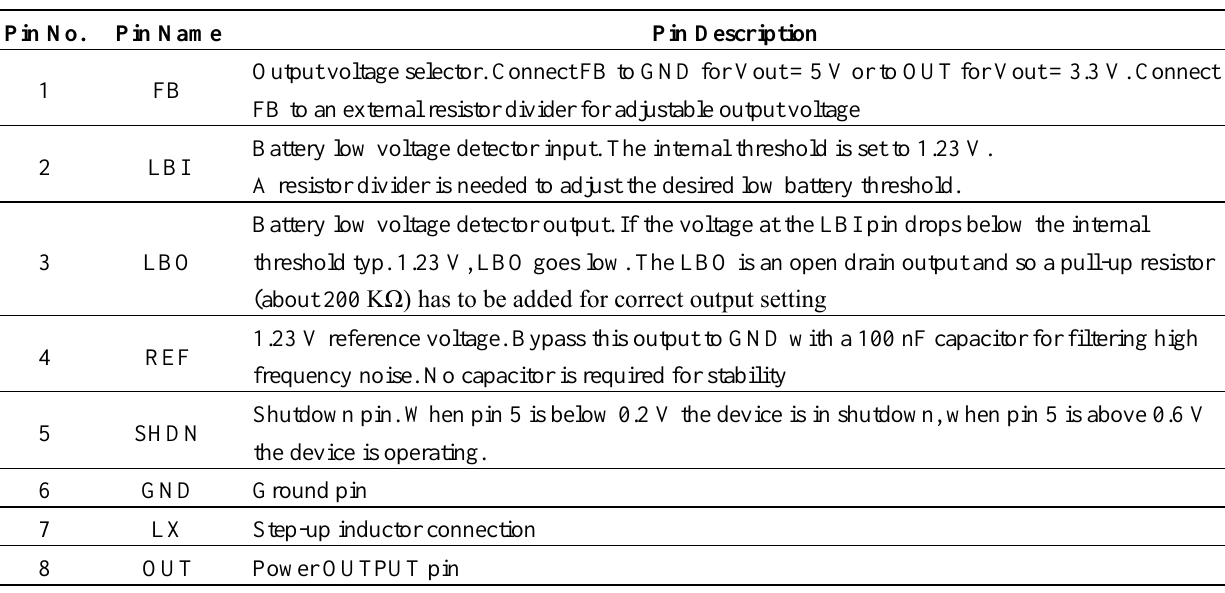
Table 2. Pins description for L6920DB [21].